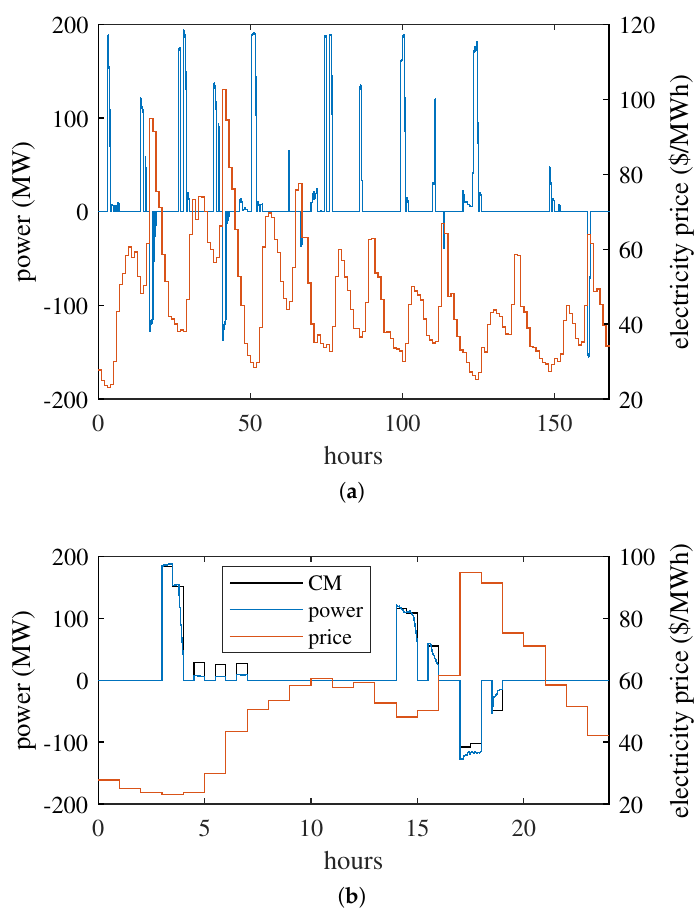
Figure 12. ( a ) The power exchanged by the fleet and the electricity price during a week for the NYISO scenario with scheduled charging; ( b ) zoom on the first day, also showing the charging module set point (CM).